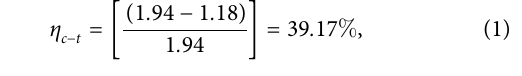
Frontiers in Energy Research |